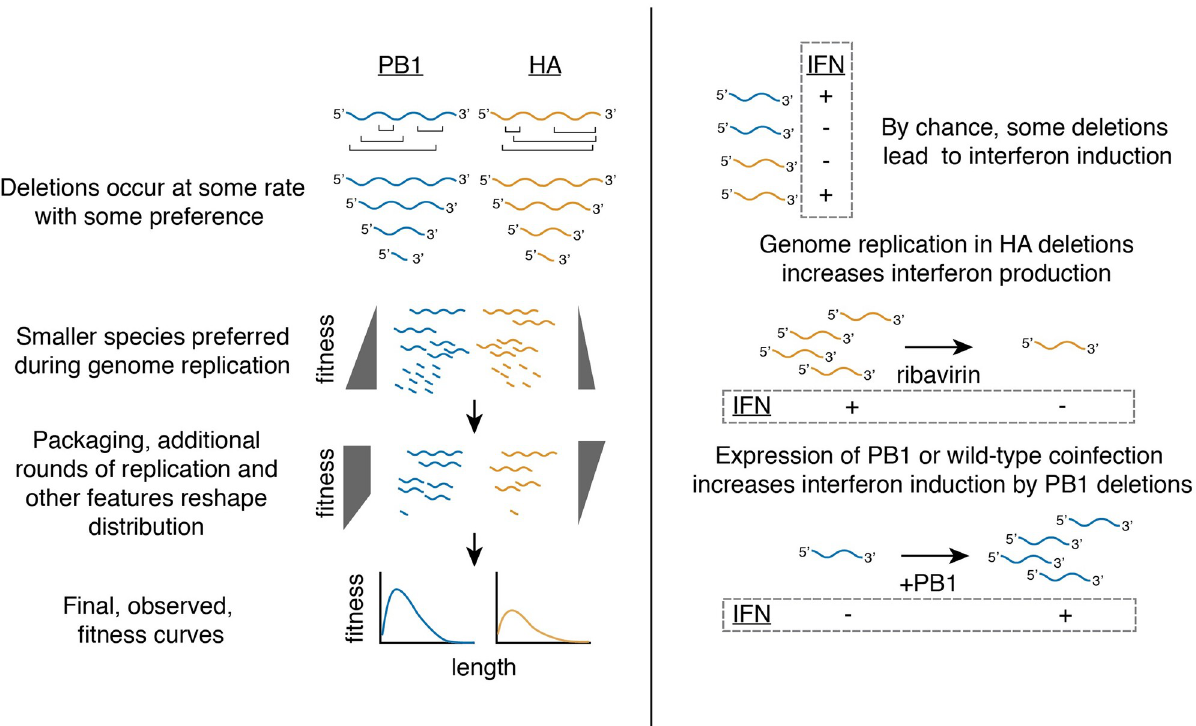
Fig 8. Summary of major conclusions. After deletions form, they are subject to selection during genome replication, which favors smaller products. As viral populations expand, different selection pressures reshape viral populations. In part, selection against small variants during packaging, observed for both PB1 and HA, contributes to this reshaping. During viral growth and expansion, very small ( < 400nt) PB1 variants are excluded, whereas the HA segment exhibits length dependence throughout, favoring larger products. Combining pressures produces a curve with a deletion fitness maximum of * 400 nt, but with a lower overall preference for HA deletions than PB1 deletions. Interferon induction by deletions appears to be largely length- independent. Genome replication modulates inteferon induction by deletions, either occuring in single infections for non-polymerase deletions, or during coinfection for polymerase